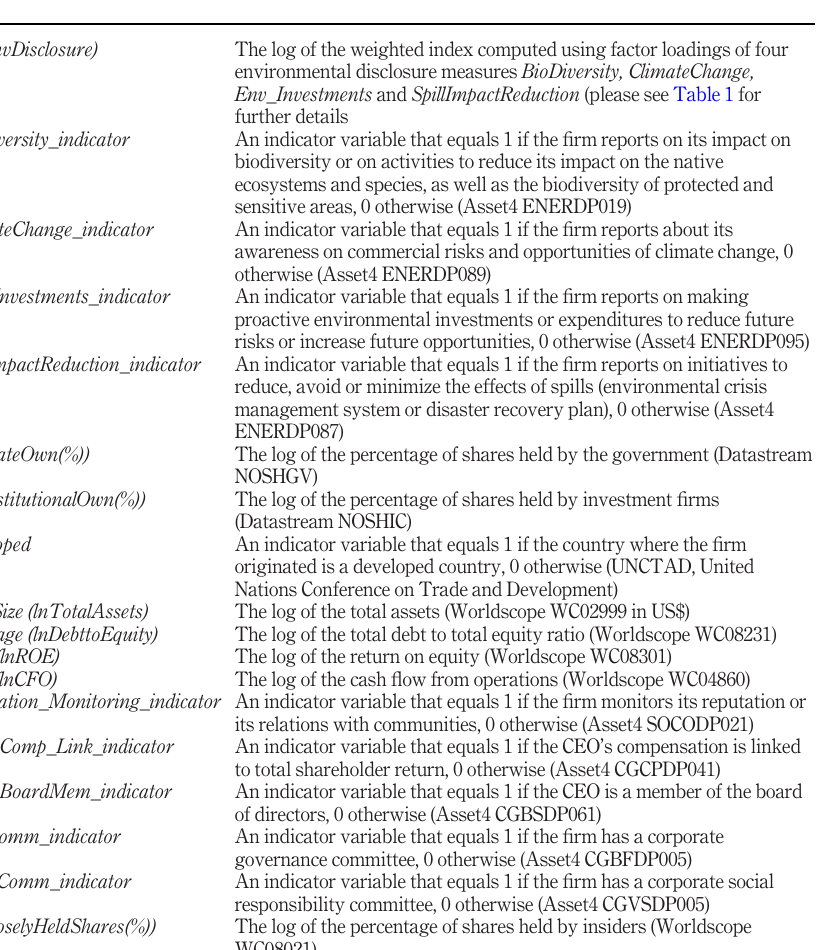
Table 2. Variable de fi